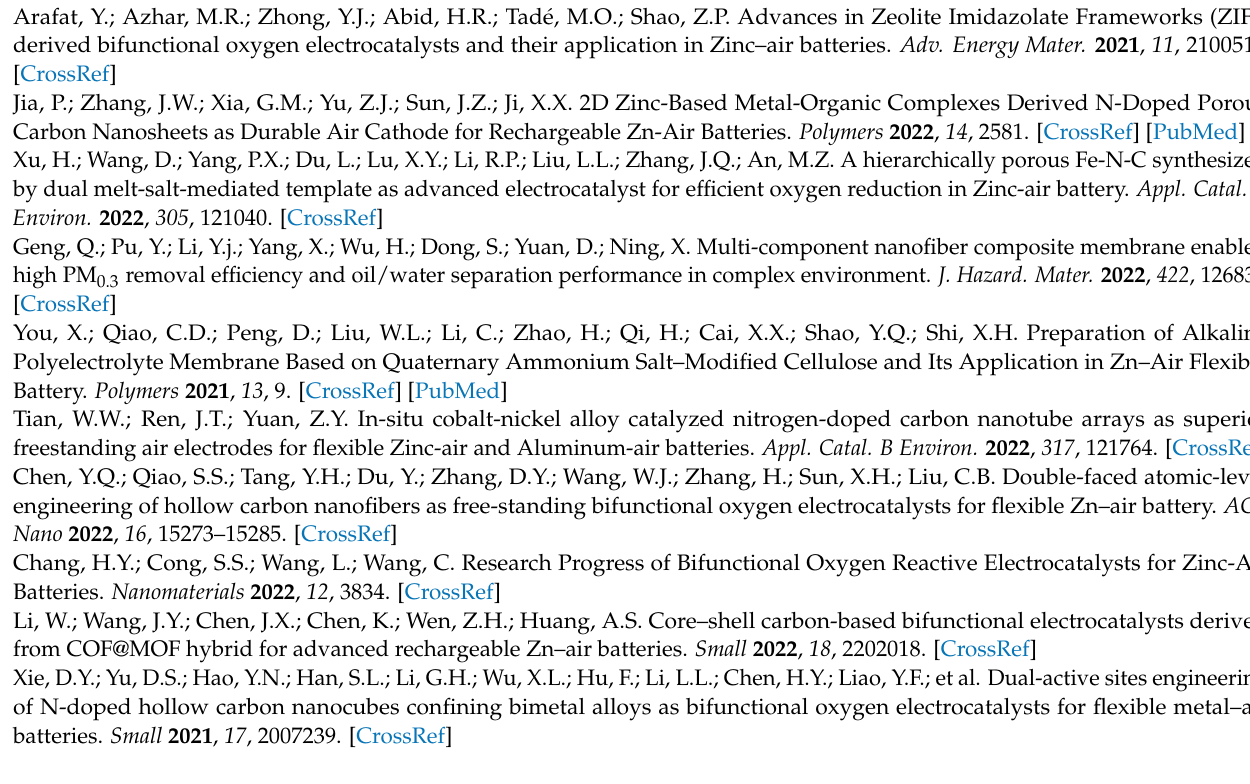
700, (b) CC/Co@NC/Co x (OH) y -700, (c) CC/Co@NC/Fe x (OH) y -700, (d) CC/CoFe-LDH-700 and (e) CC/Co@NC at different scan rates in the non-Faradaic potential; Figure S7: CV curves of CC/Co@NC/CoFe-LDH-700 in N 2 - and O 2 - saturated 0.1 M KOH at a scan rate of 50 mV · s − 1 ; Figure S8: ORR polarization curves of CC/Zn, Co-MOF and CC/Co-MOF derived catalysts at a rotation speed of 1600 rpm; Figure S9: ORR polarization curves of CC/Co@NC/CoFe-LDH under different electrodeposition times at a rotation speed of 1600 rpm; Table S1: Comparison of the specific surface area of the CC/Co@NC/CoFe-LDH -700 with previously reported electrocatalysts; Table S2: Comparison of η 50 between CC/Co@NC/CoFe-LDH-700 and other recently reported OER electro- catalysts; Table S3: Comparison of the ORR catalytic activity of the CC/Co@NC/CoFe-LDH-700 with previously reported electrocatalysts; Table S4: Comparison of the performance of liquid ZABs based on different air